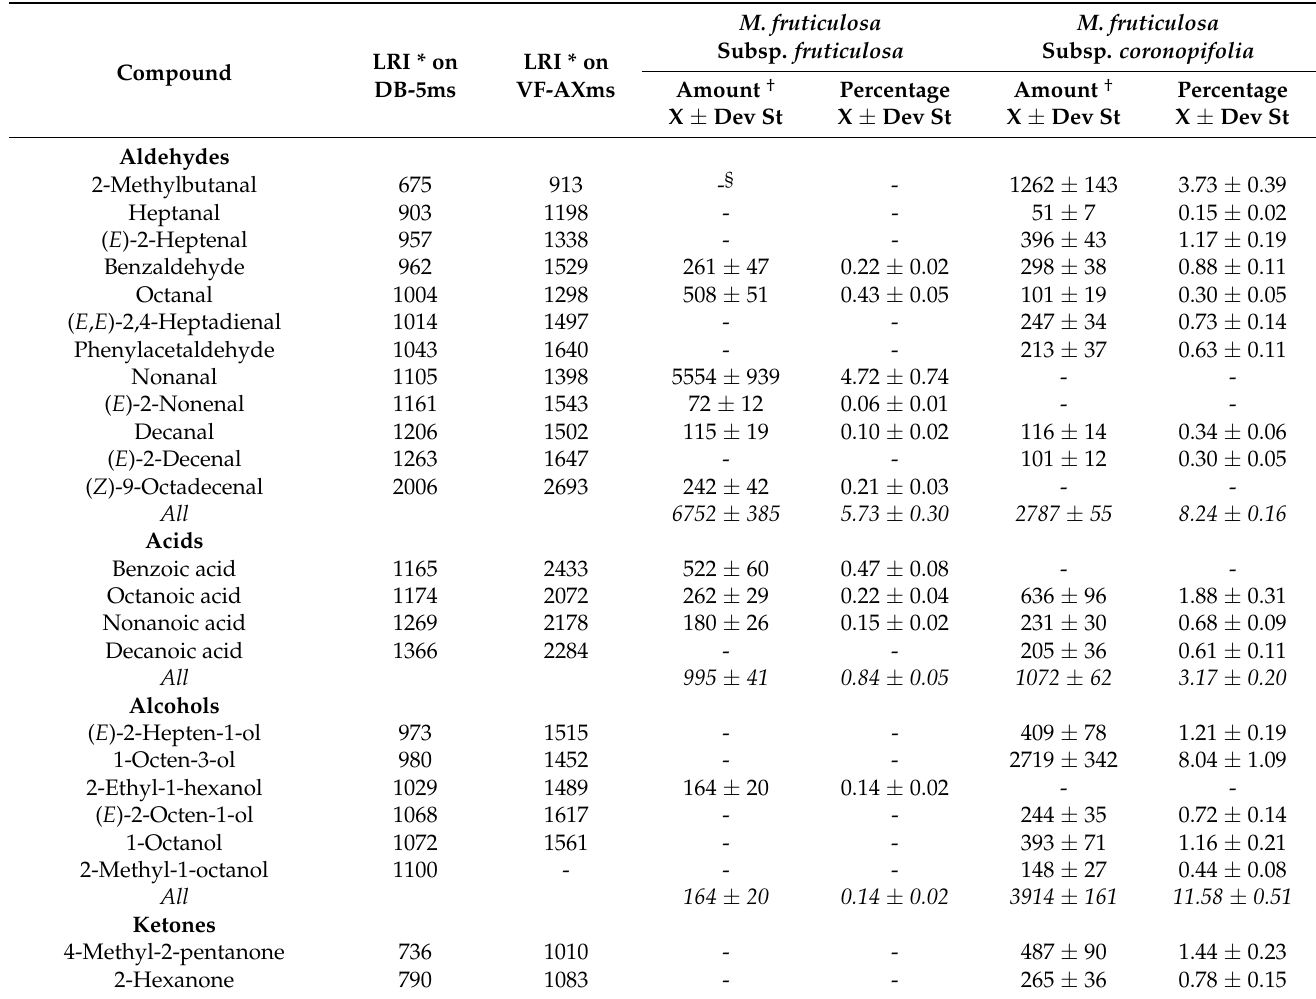
Table 2. Composition as volatile constituents and classes of substances of the hydroalcoholic extracts obtained from the aerial parts of M. fruticulosa subsp. fruticulosa and subsp. coronopifolia .